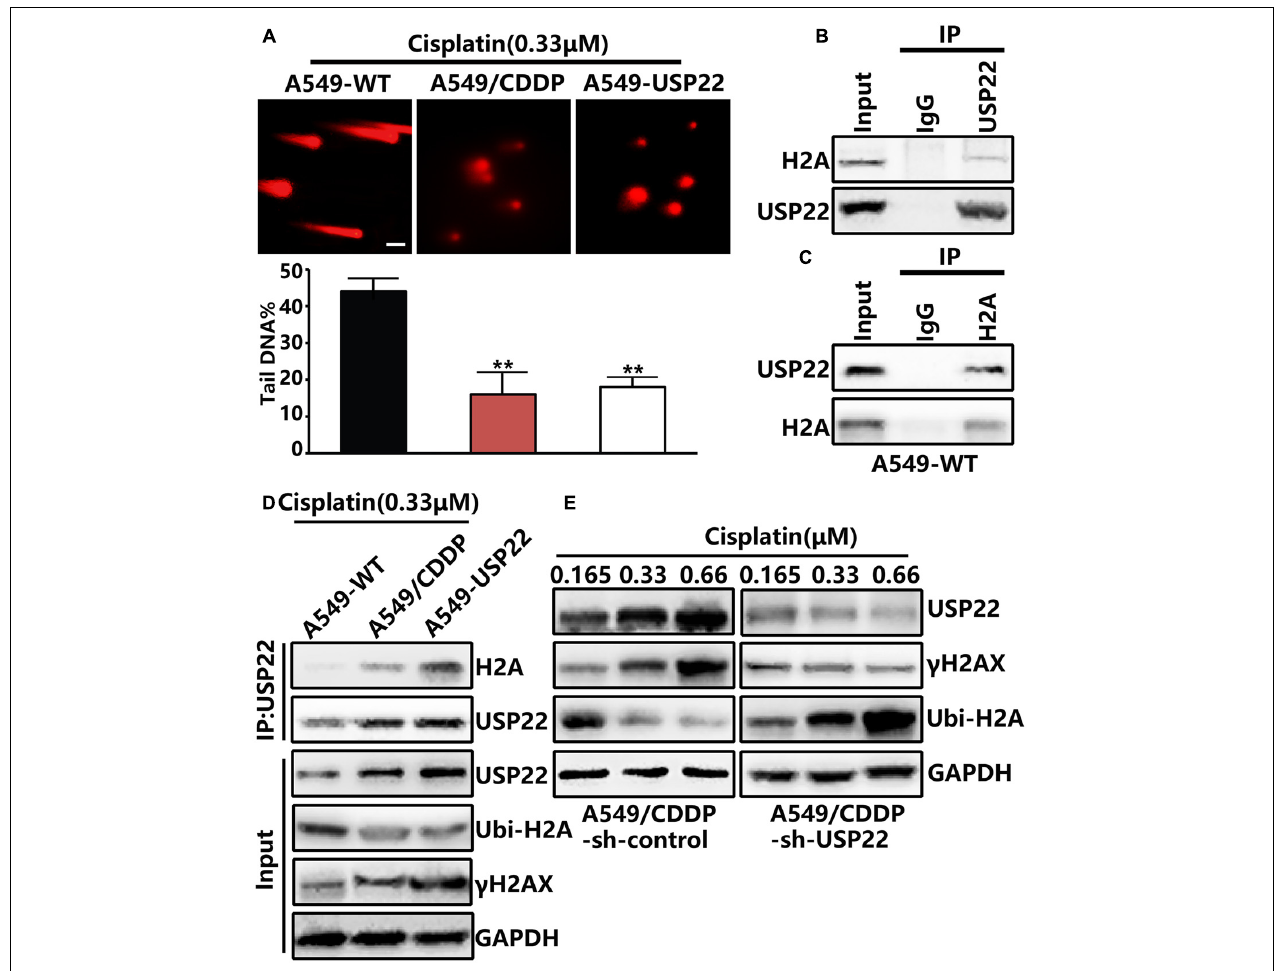
FIGURE 3 | USP22 enhances DNA damage repair and induce cisplatin resistance by promoting the phosphorylation of histone H2AX via deubiquitinating histone H2A. (A) Comet assay was performed to assess DNA damage after 0.33 µ M cisplatin treatment for 6 h in A549-WT, A549-USP22, and A549/CDDP cells (scale bar 20 µ M). (B,C) H2A interacts with USP22 in A549-WT cells. A549-WT cells lysates were subjected to immunoprecipitation (IP) with control IgG, anti-USP22 (B) , and anti-H2A (C) antibodies. The immunoprecipitates were then blotted with the indicated antibodies. (D) H2A binding to USP22, γ H2AX, and the ubiquitination of H2A (Lys119) was detected by IP and western blot after 0.33 µ M cisplatin treatment for 48 h in A549-WT, A549/CDDP and A549-USP22 cells. (E) Western blot analysis of the proteins of USP22, γ H2AX and Ubi-H2A after various concentrations of cisplatin treatment for 48 h.